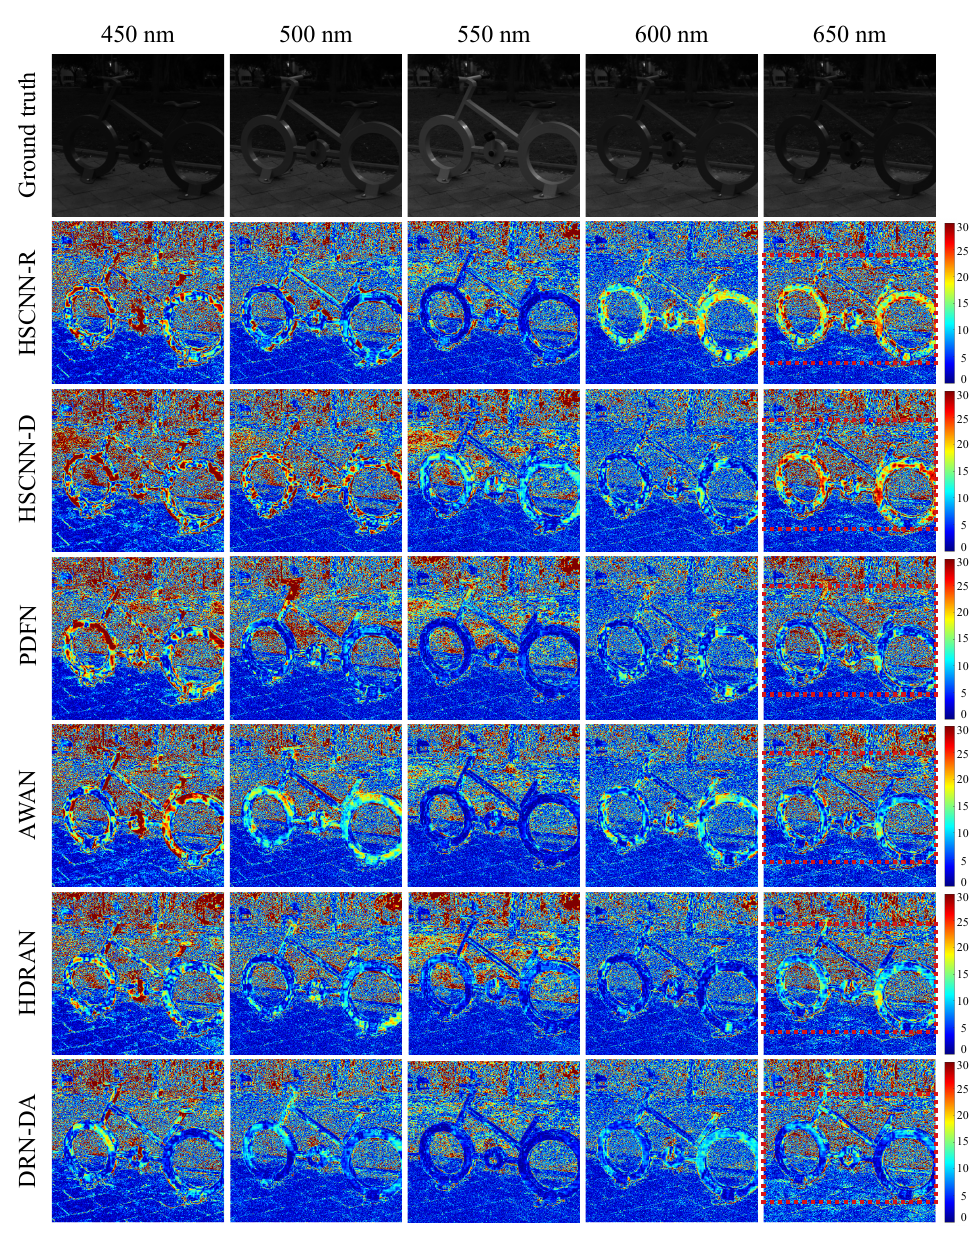
Figure 9. Visual hyperspectral reconstruction results and visual comparisons of five selected bands for hyperspectral reconstruction error maps from one NTIRE 2020 “Real World” RGB image. The significant differences are shown in the red frames. Please zoom in for better view.